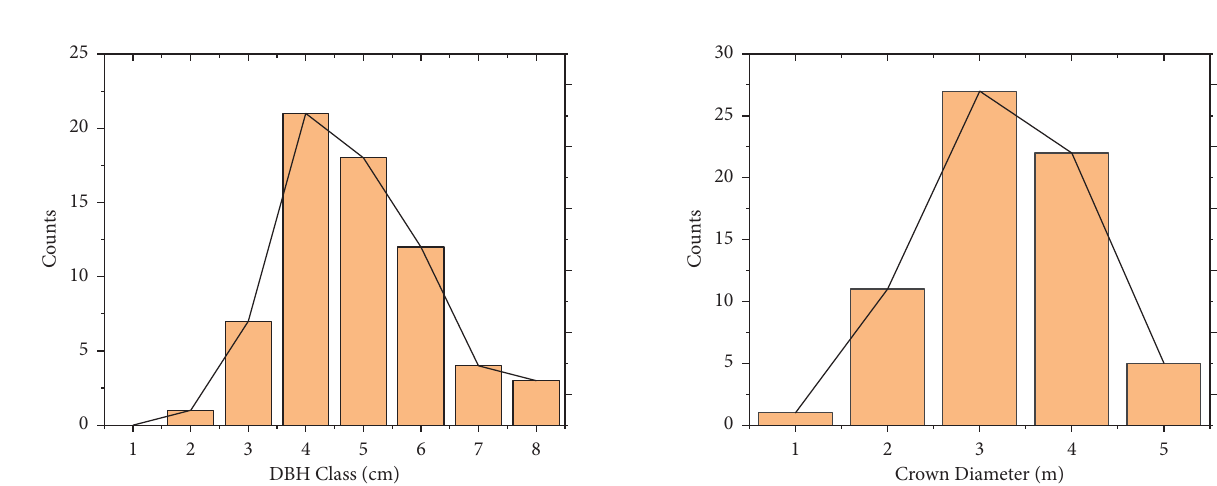
Figure 5: DBH classes distribution (1 < 10, 2 � 11–20, 3 � 21–30,